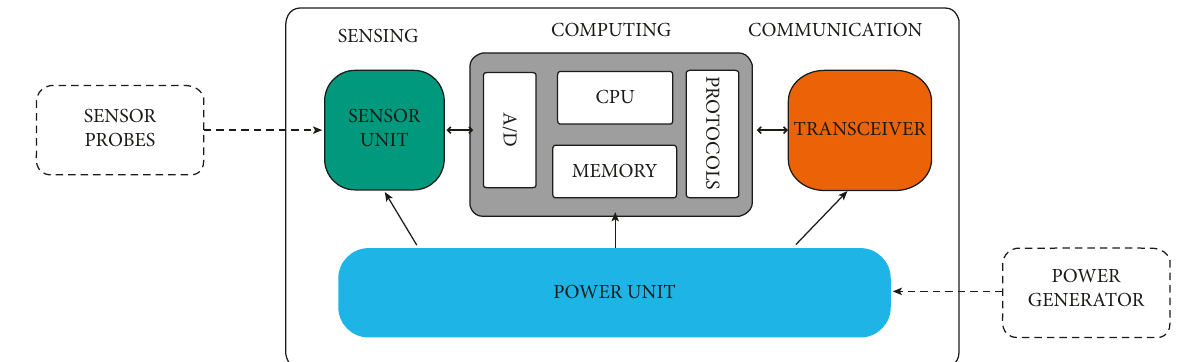
Figure 3: Components of a wireless sensor